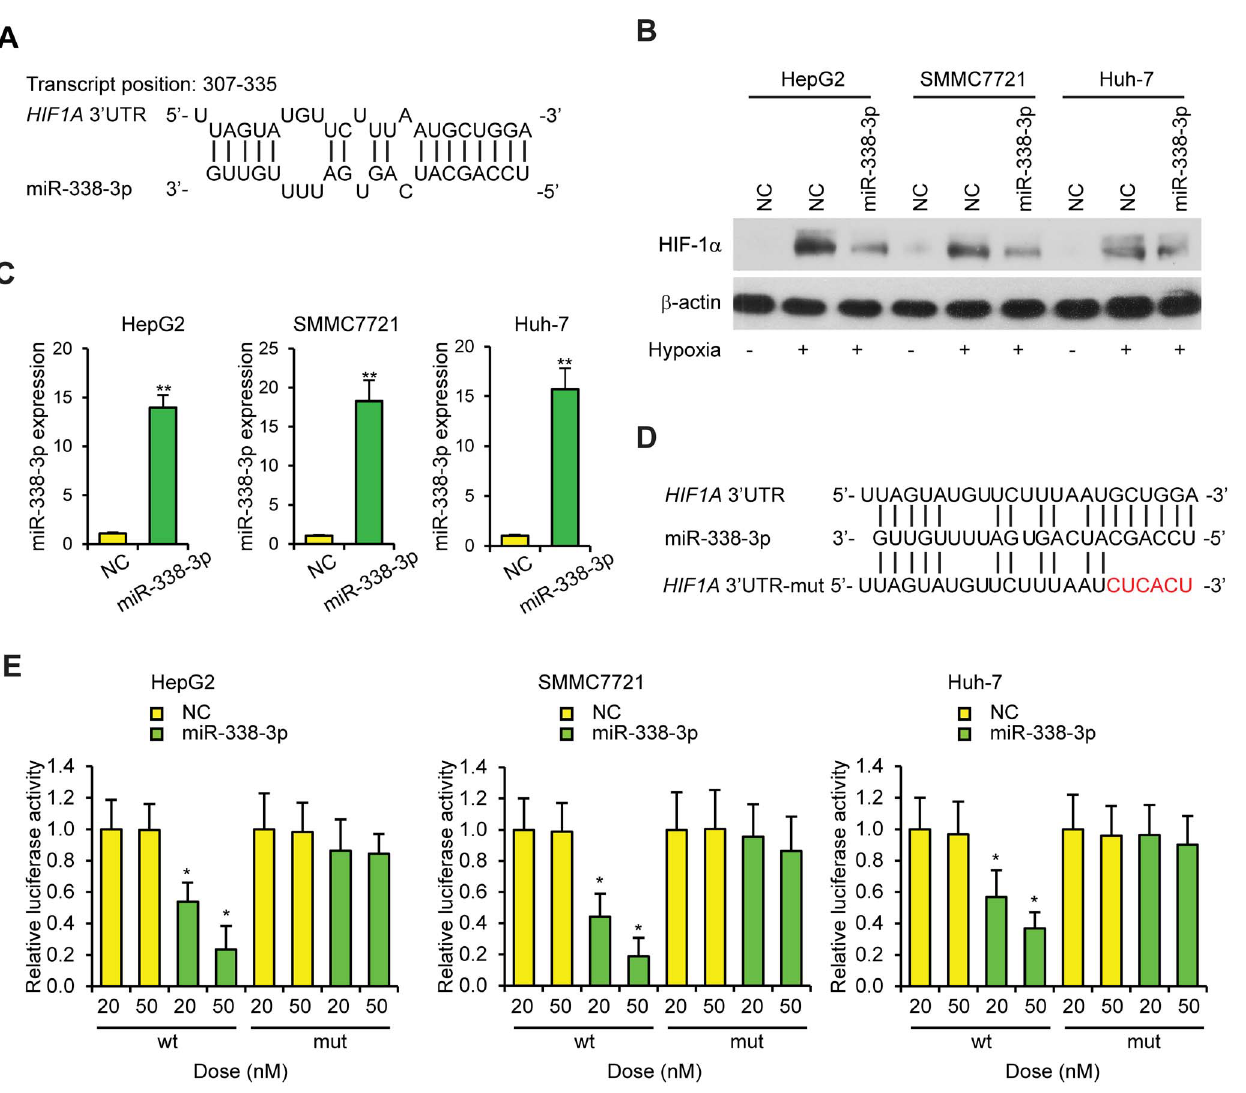
Fig. 2. miR-338-3p suppresses HIF-1 a expression by directly targeting the HIF1A 3 9 UTR. (A) Predicted miR-338-3p target sequences in the HIF1A 3 9 UTR. (B) Western blot analysis of HIF-1 a levels in NC- or miR-338-3p-transfected cells. b -actin was used as loading control. Cells were cultured under hypoxia at two days post-transfection with cells cultured under normoxia as reference, and 24 h later protein levels were analyzed. (C) Relative miR-338-3p levels in miR-338-3p mimic transfected HCC cells. Transcript levels were normalized to U6 expression. n 5 4. (D) Six nucleotides (red) of HIF 3 9 UTR were mutated to prevent binding with miR-338-3p. (E) Luciferase reporter assay of cells transfected with the wild type (wt) or mutant (mut) HIF1A 3 9 UTR luciferase reporter plasmid with increasing amounts (20 to 50 nM) of negative control miRNA (NC) or miR-338-3p in HCC cells two days post-transfection; n 5 4. **p # 0.01 compared to NC group. Data are shown as mean ¡ SEM of three independent experiments.